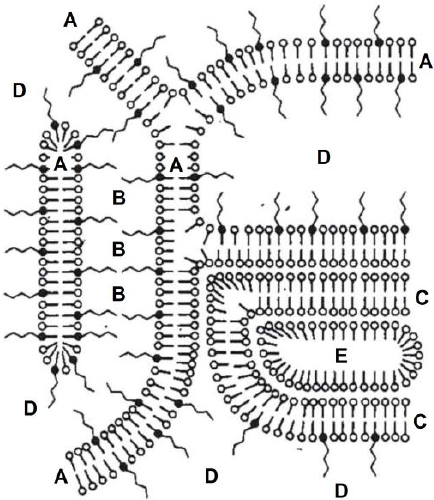
Figure 2. Model structure of the nonionic hydrophilic cream (NHC) according to the German Pharmacopeia (DAB) modified according to Junginger [7]: (A) mixed crystal of polysorbate 60 and cetolstearyl alcohol, (B) interlamellarly fixed water, (C) lipophilic gel phase, (D) bulk water, (E) lipophilic dispersed phase.